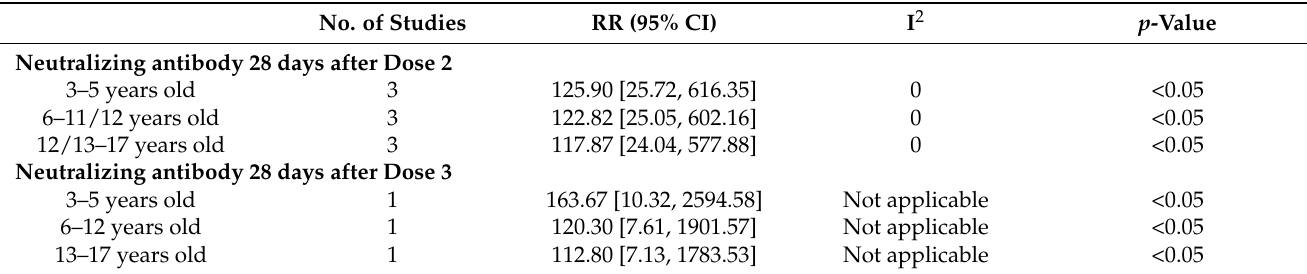
Table 11. Neutralizing antibody in the inactivated vaccine groups versus the control groups.